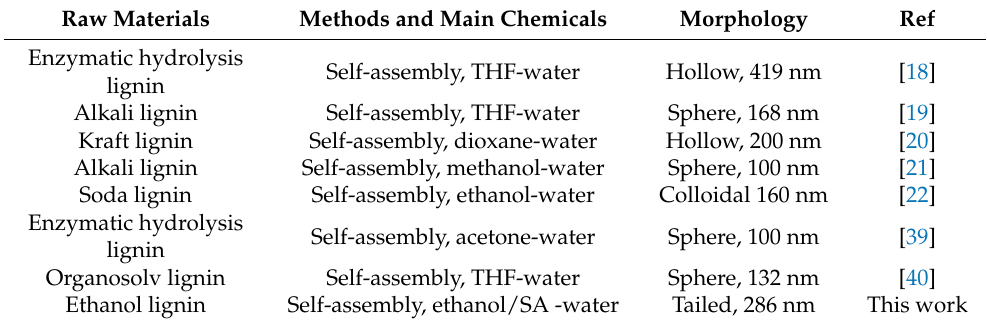
Figure 4. Particle average diameter, ζ , PDI analysis of ( a ) 0T − LNP, ( b ) 3T − LNP, ( c ) 6T − LNP, and ( d ) 9T − LNP. Table 2. Morphological comparison of lignin nanoparticles prepared by various representative chemicals.